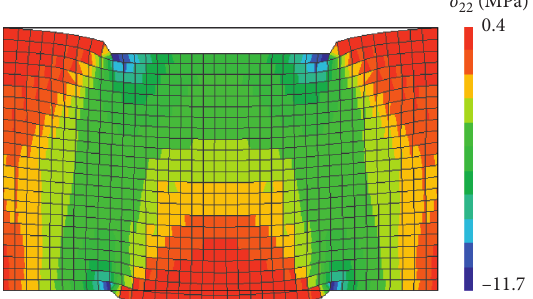
Figure 12: Deformed configuration and vertical normal stresses at P � 100kN load level performed with the FE-TSRCM. p = 0.30MPa